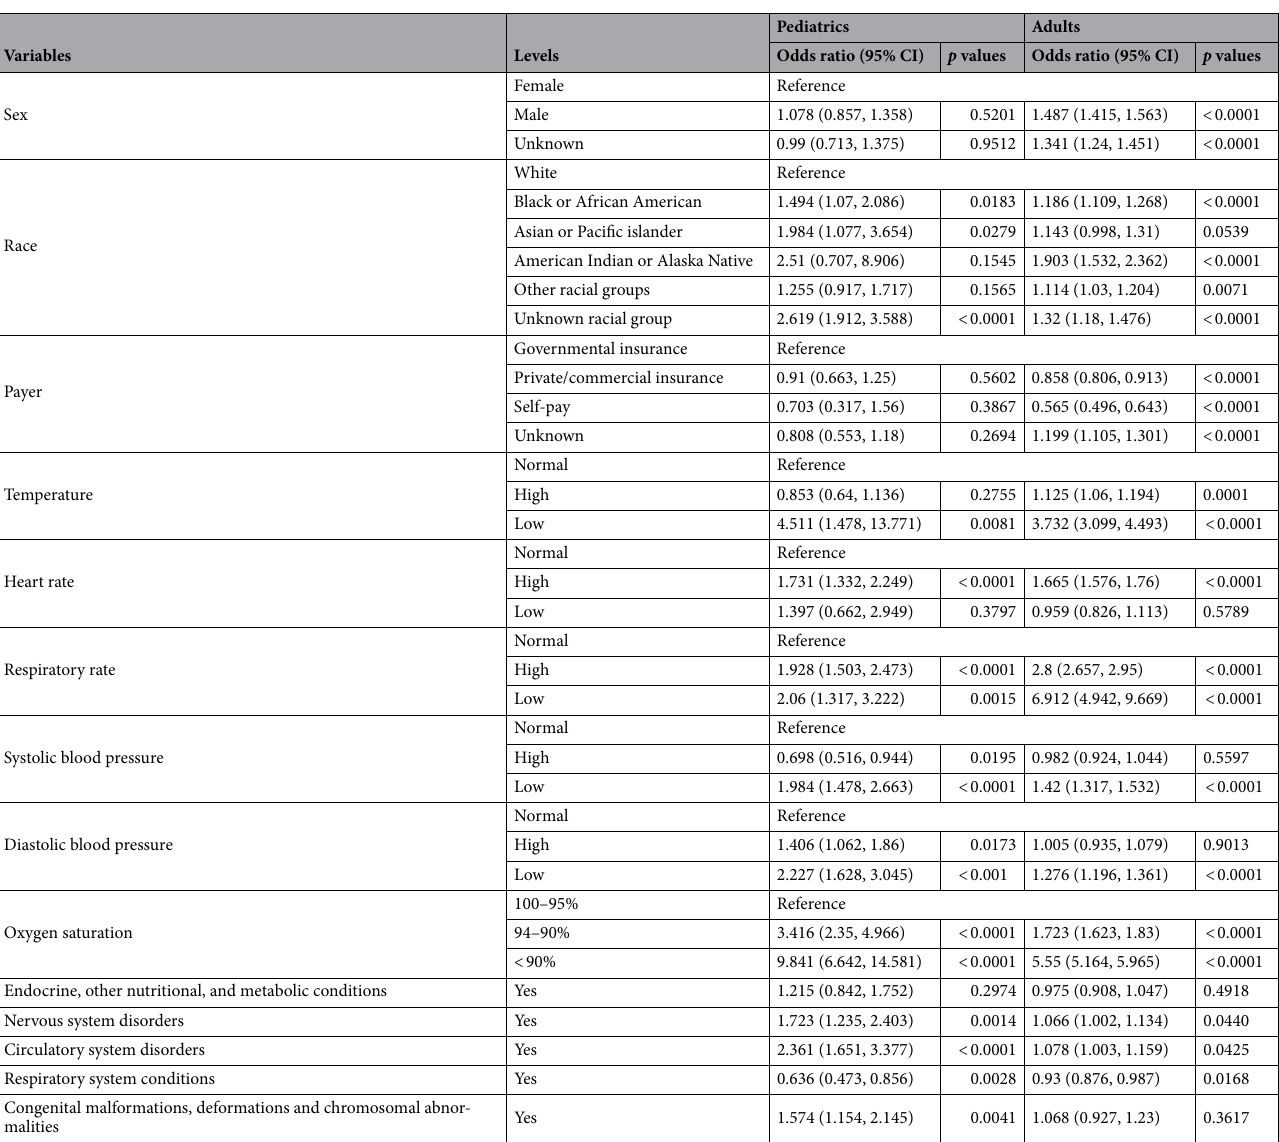
Table 3. Peripheral results on variables controlled for in the random intercept model for